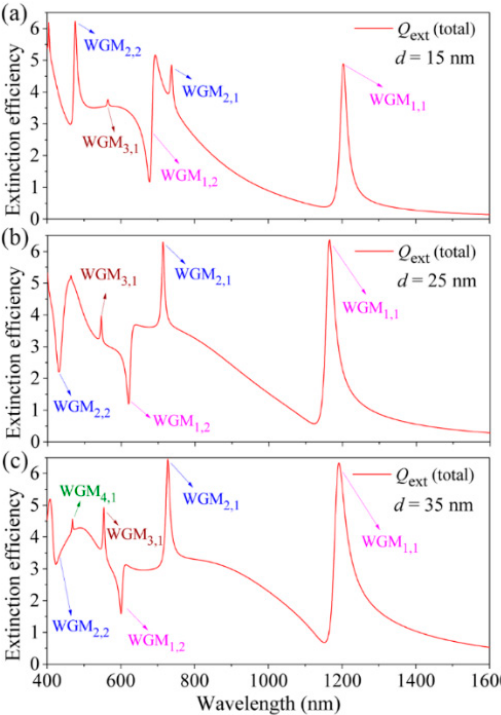
Figure 6. ( a – c ) The calculated total extinction efficiency spectra of the spherical HMM cavity for different d from 15 nm ( a ) and 25 nm ( b ) to 35 nm ( c ), respectively. Other structural/material parameters: r = 20 nm, s = 20 nm and n = 1.4.